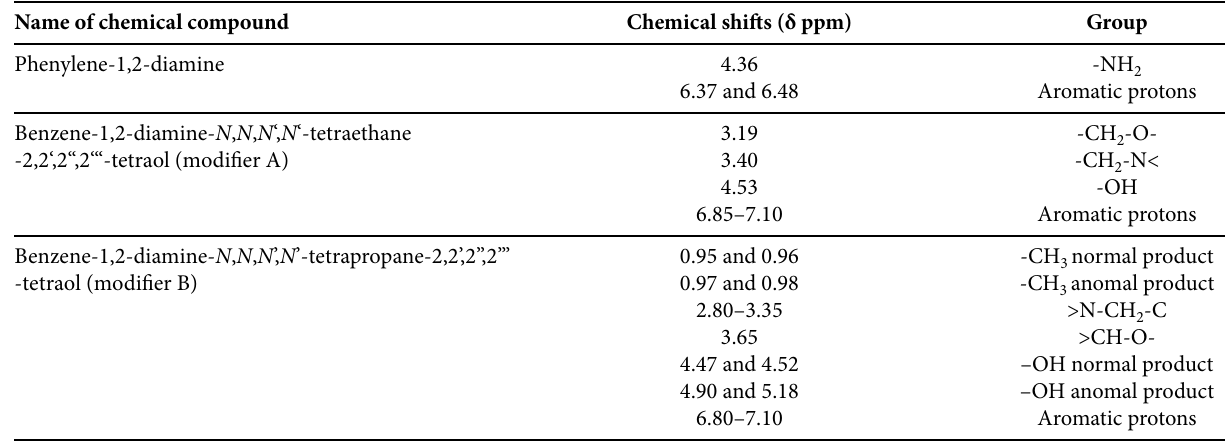
Table 3. Chemical Shifts of Protons in 1 H NMR Spectra of Phenylene-1,2-diamine and obtained Modifiers Name of chemical compound